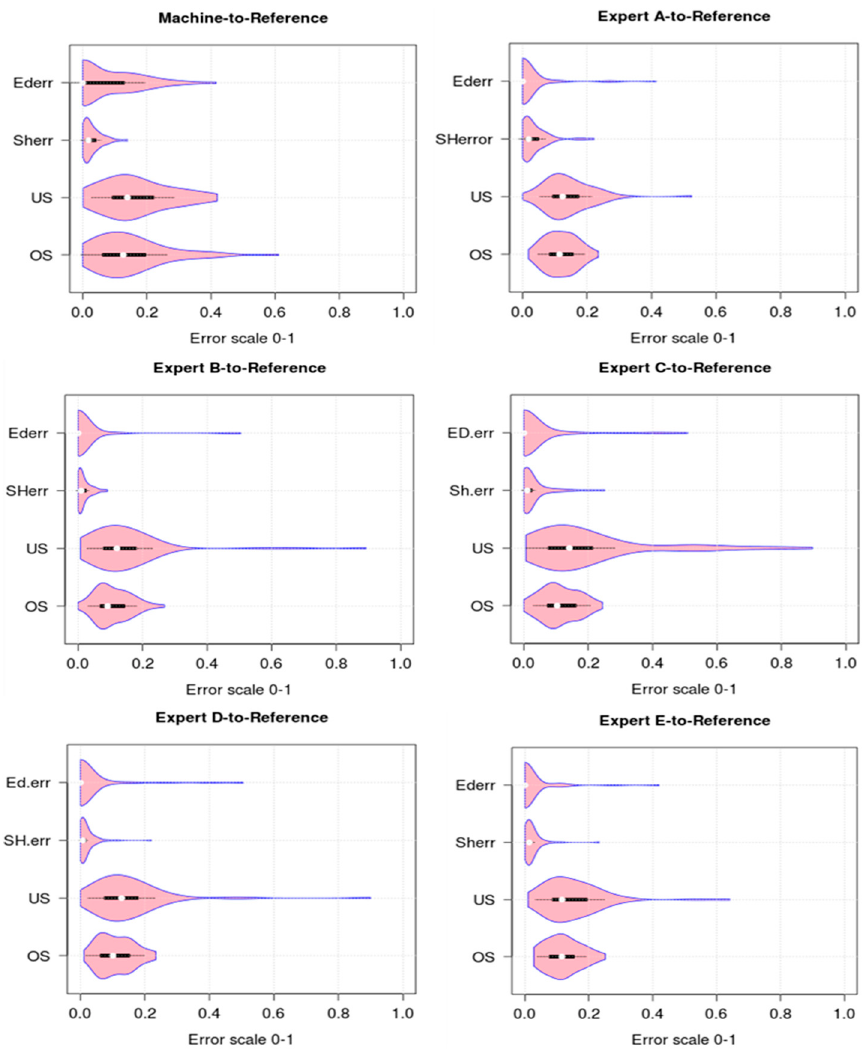
Figure 11. Clustering of geometric discrepancies. Ederr: edge error; SHerr: shape error; US: under segmentation and OS: over segmentation.